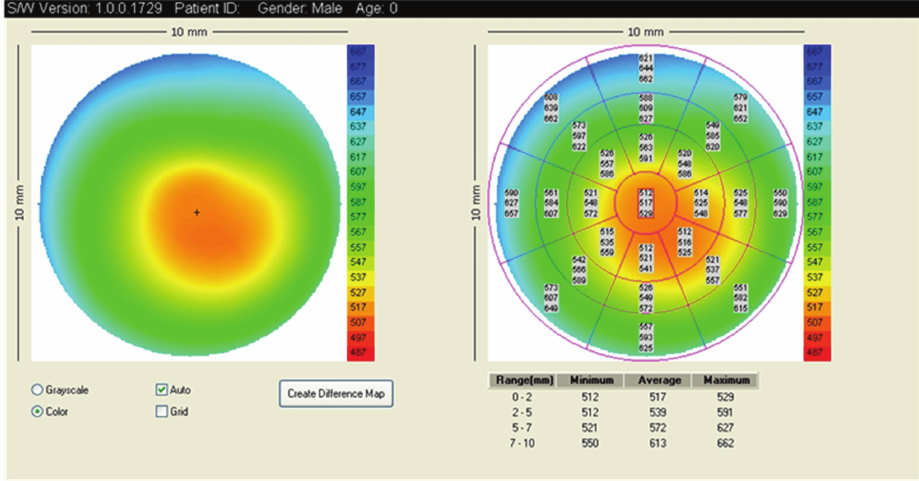
Figure 12: AS-OCT: pachymetry